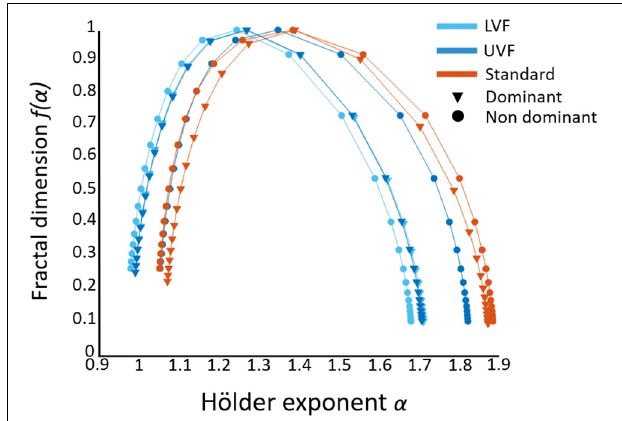
FIGURE 5 | Average singularity spectra obtained from FMF–DFA in the three conditions (distinguished by colors) for both hands (distinguished by markers).